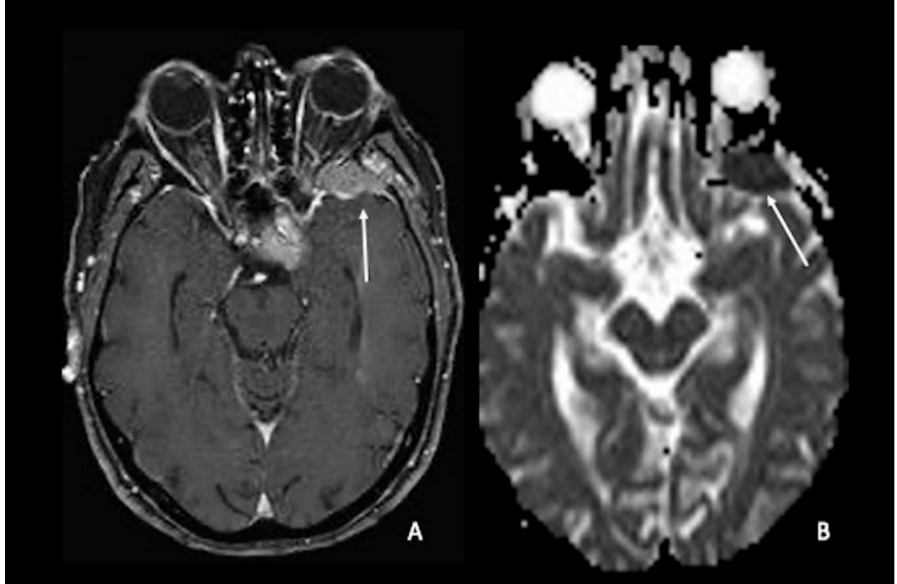
Figure 5. Aggressive meningioma: ( A ) atypical or malignant meningiomas (arrow) could have ( B ) lower ADC values than normal brain parenchyma (arrow). ADC = apparent diffusion coefficient.